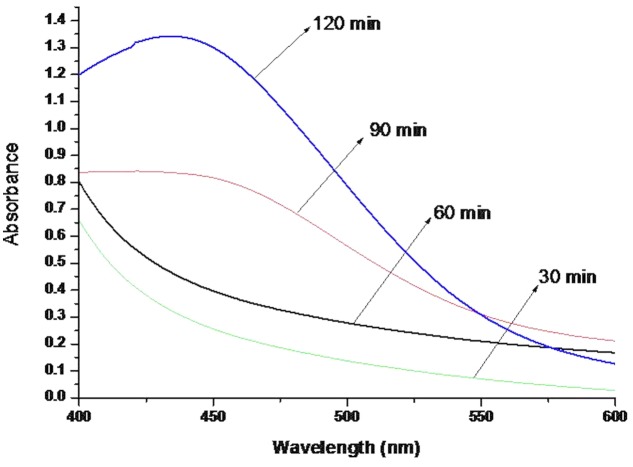
UV-Vis spectra of AgNPs synthesized by P. serratum.